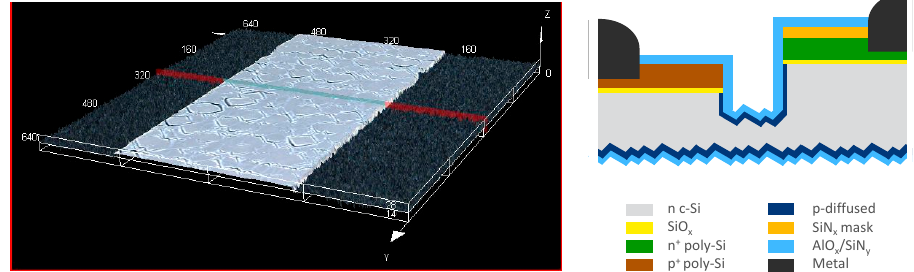
Figure 8. Laser-scanning micrograph of a surface of the laser-densified boron-doped poly-Si layer (light area) surrounded by etched layers (dark areas) ( left ) and cross-section of the poly-ZEBRA (TBC) structure ( right ).